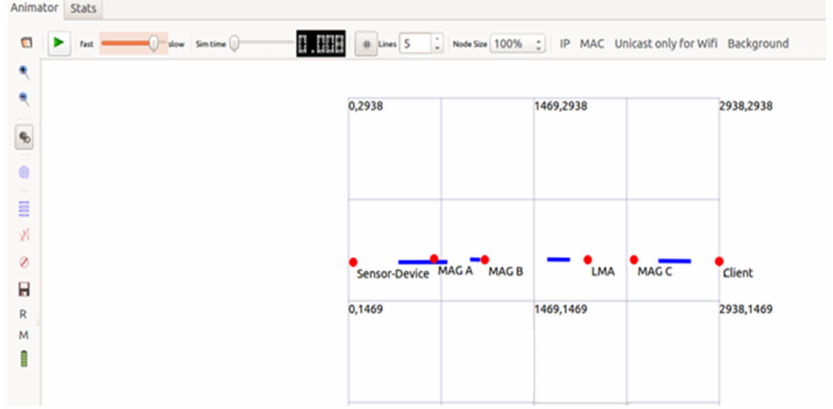
Figure 5. CoAP-PMIPv6 before handover (NetAnim view).